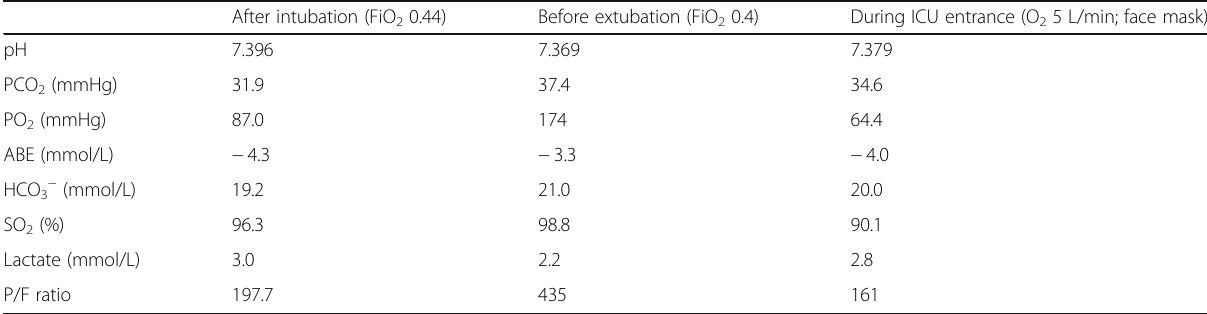
Table 1 Gas analysis results obtained from the patient ’ s arterial blood at various events during her hospital stay